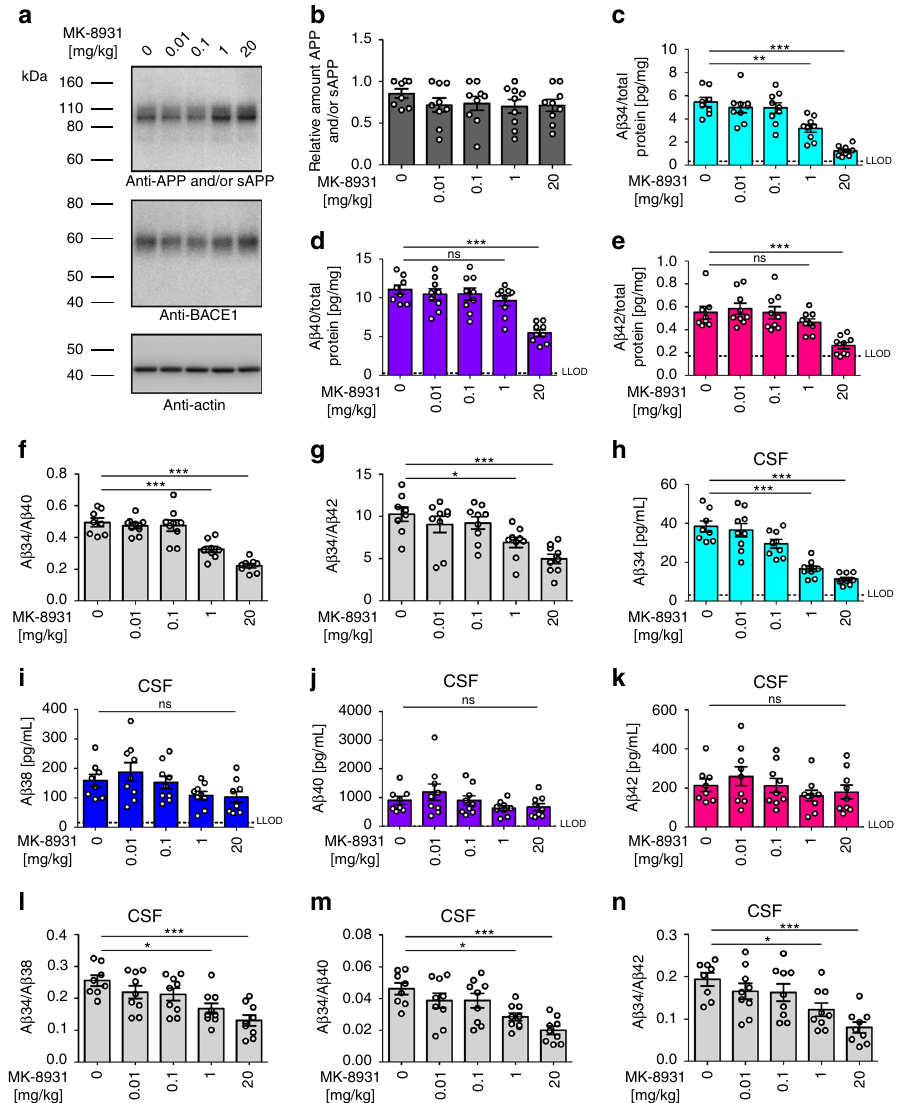
Fig. 2 Pharmacological inhibition of A β 34 generation in rats. Endogenous levels of APP and/or sAPP, BACE1, and A β in rats 1 h after intravenous injection of the indicated concentrations (mg/kg) of the BACE1-speci fi c inhibitor (MK-8931) n = 9 animals per group or vehicle n = 8 animals. Western blot of endogenous APP and/or sAPP and BACE1 expression ( a ) and corresponding quanti fi cation of relative protein amounts of APP and/or sAPP ( b ). Quanti fi cation (pg/mg total protein) of absolute amounts of A β 34 ( c ), A β 40 ( d ), and A β 42 ( e ) as determined by custom MSD multiplexing assays. Ratios of A β 34/A β 40 ( f ) and A β 34/A β 2 ( g ) are displayed. Quanti fi cation of CSF levels of A β 34 ( h ), A β 38 ( i ), A β 40 ( j ), and A β 42 ( k ), as well as display of the ratios A β 34/A β 38 ( l ), A β 34/A β 40 ( m ), and A β 34/A β 42 ( n ). Statistics: b one-way ANOVA, F (4, 39) = 0.63, p > 0.05, c one-way ANOVA, F (4, 39) = 22.40, p < 0.0001, d one-way ANOVA, F (4, 39) = 12.81, p < 0.0001, e one-way ANOVA, F (4, 39) = 9.38, p < 0.0001, f one-way ANOVA, F (4, 39) = 25.93, p < 0.0001, g one-way ANOVA, F (4, 39) = 8.02, p < 0.0001, h one-way ANOVA, F (4, 39) = 26.55, p < 0.0001, i one-way ANOVA, F (4, 39) = 2.69, p < 0.05, j one-way ANOVA, F (4, 39) = 1.71, p > 0.05, k one-way ANOVA, F (4, 39) = 1.09, p > 0.05, l one-way ANOVA, F (4, 39) = 6.87, p < 0.001, m one-way ANOVA, F (4, 39) = 7.36, p < 0.001, n one-way ANOVA, F (4, 39) = 6.74, p < 0.001. Bars and error bars indicate mean ± s.e.m. Tukey ’ s post-hoc tests were performed for pairwise comparisons; selected comparisons are highlighted *** p < 0.001, ** p < 0.01, * p < 0.05, ns = nonsigni fi cant p >